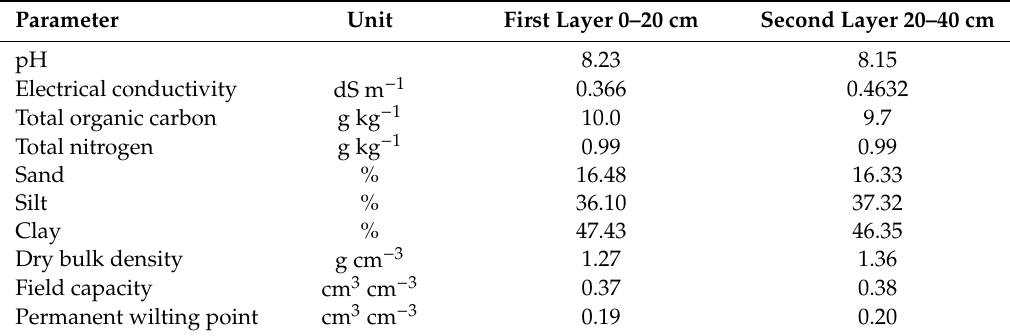
Table 1. Physical and chemical of soil